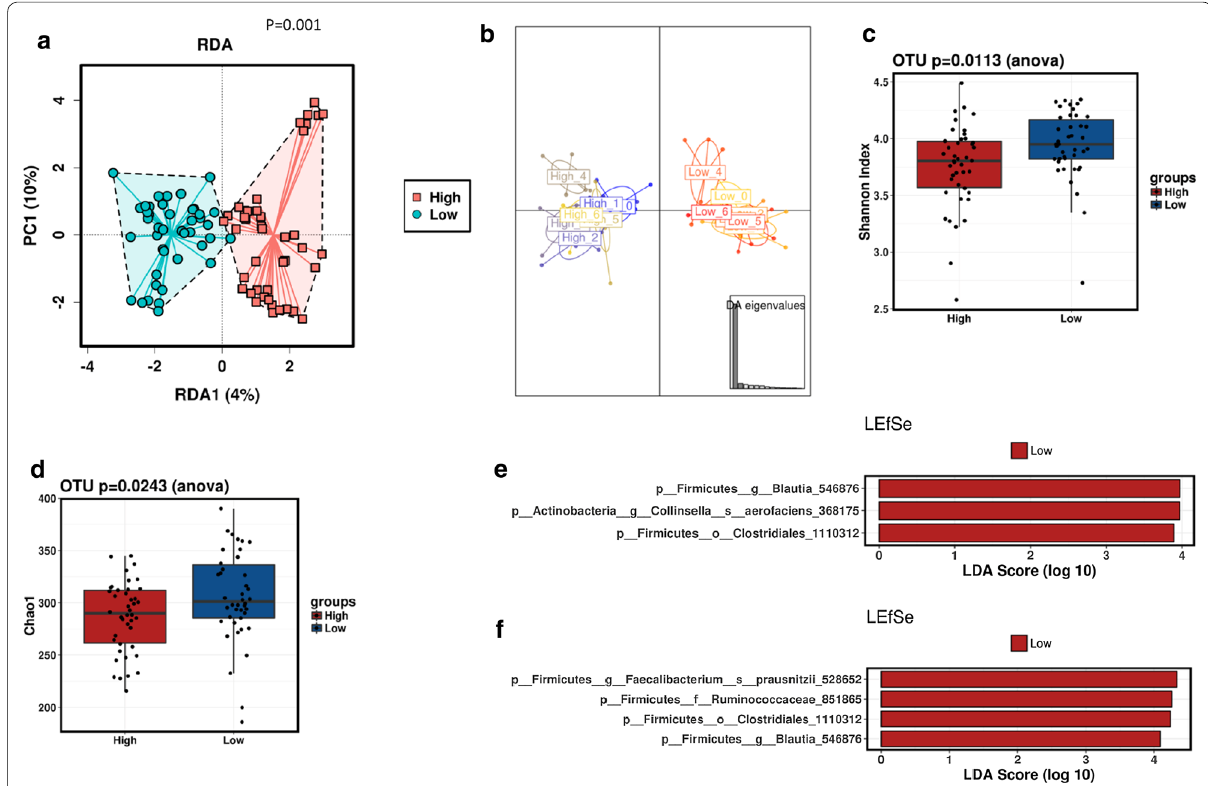
Fig. 3 Microbiota composition and diversity after interventions and according to stool zonulin levels. Redundancy discriminant analysis (RDA) to divide probands into groups according to high or low zonulin group and intervention over all samples ( a ), Discriminant analysis of principal components (DAPC) plot ( b ), alpha diversity according to high or low zonulin group and intervention over all samples, Shannon index ( c ) and Chao1 ( d ), linear discriminant analysis (LDA) combined with effect size measurements (LeFSe) revealed specific bacterial groups at OTU level related to the low zonulin level group at baseline ( e ) and after gluten intervention ( f ). 0, baseline, 1, after intervention with gluten, 2–6, after intervention with gluten and different cofactors, 2, proton pump inhibitor, 3, acetyl salicylic acid, 4, alcohol, 5, aerobic exercise, 6, anaerobic exercise, OTU operational taxonomic